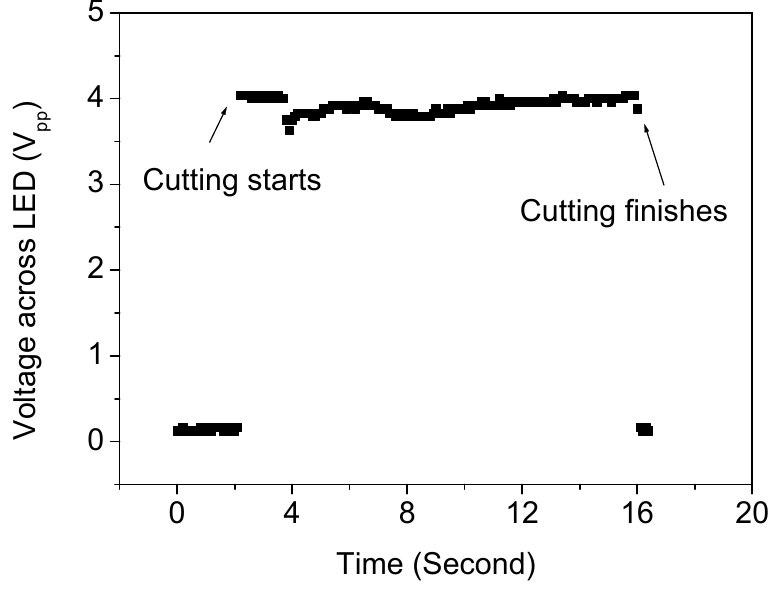
Figure 12. The variation of the voltage signal across the LEDs during the cutting process.